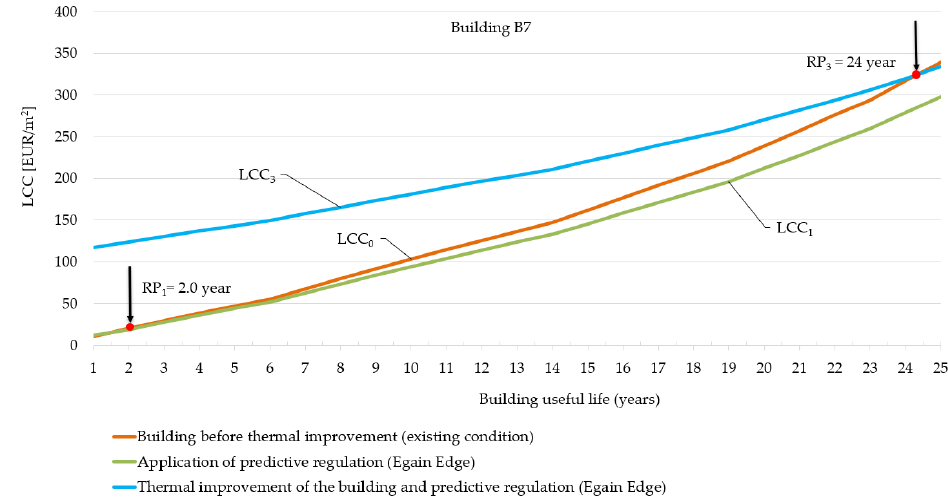
Figure 9. Life cycle costs LCC 0 , LCC 1 and LCC 3 using building B7 as an example.